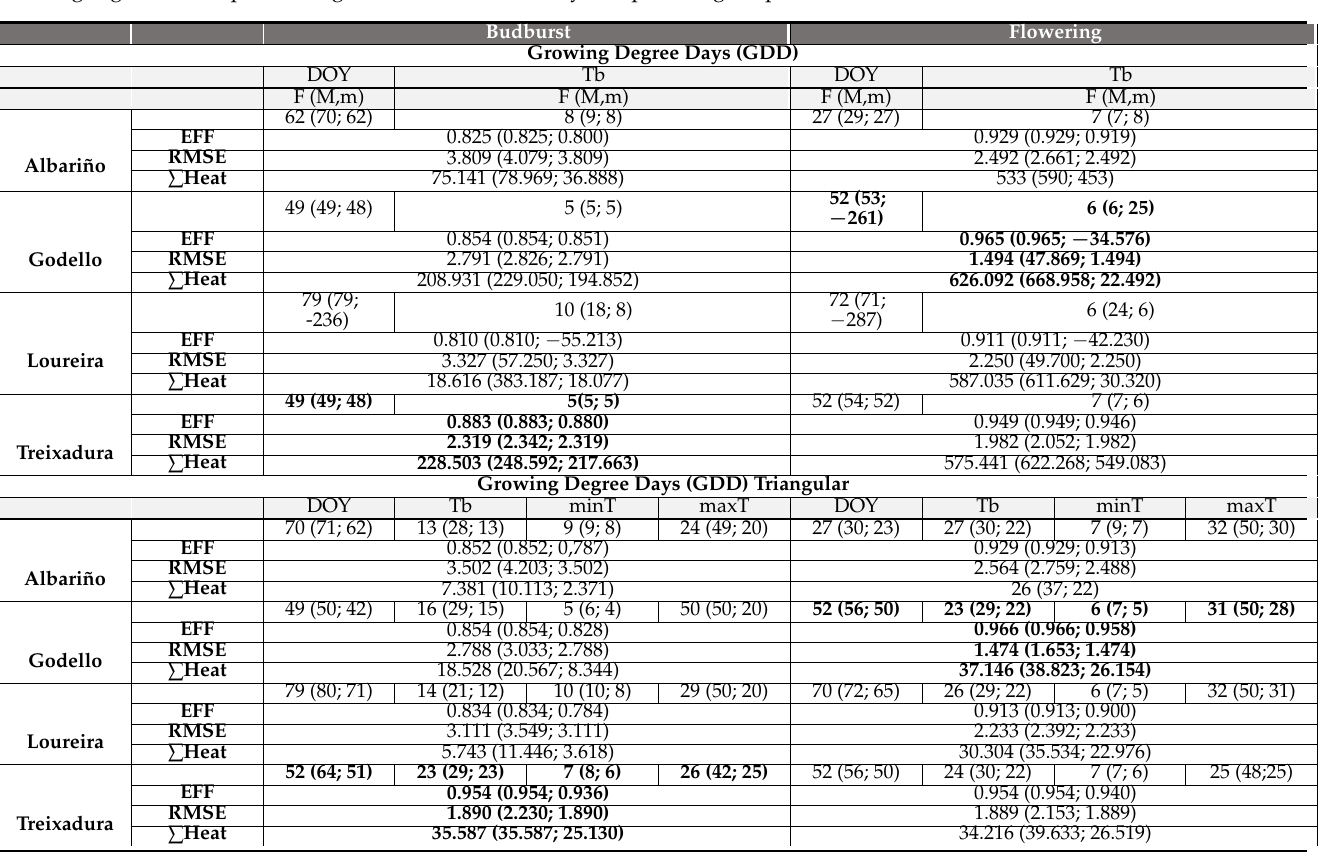
Table 1. Results of the estimation process for the three models studied for the Budburst and Flowering phenological phases. DOY: day of the year, Tb: base temperature, F: fitted, (M, m): maximum and minimum, maxT: maximum temperature, minT: minimum temperature, d: defines the sharpness of the response curve and e: mid-response temperature. The bold letters highlight the best performing models for each variety and phenological